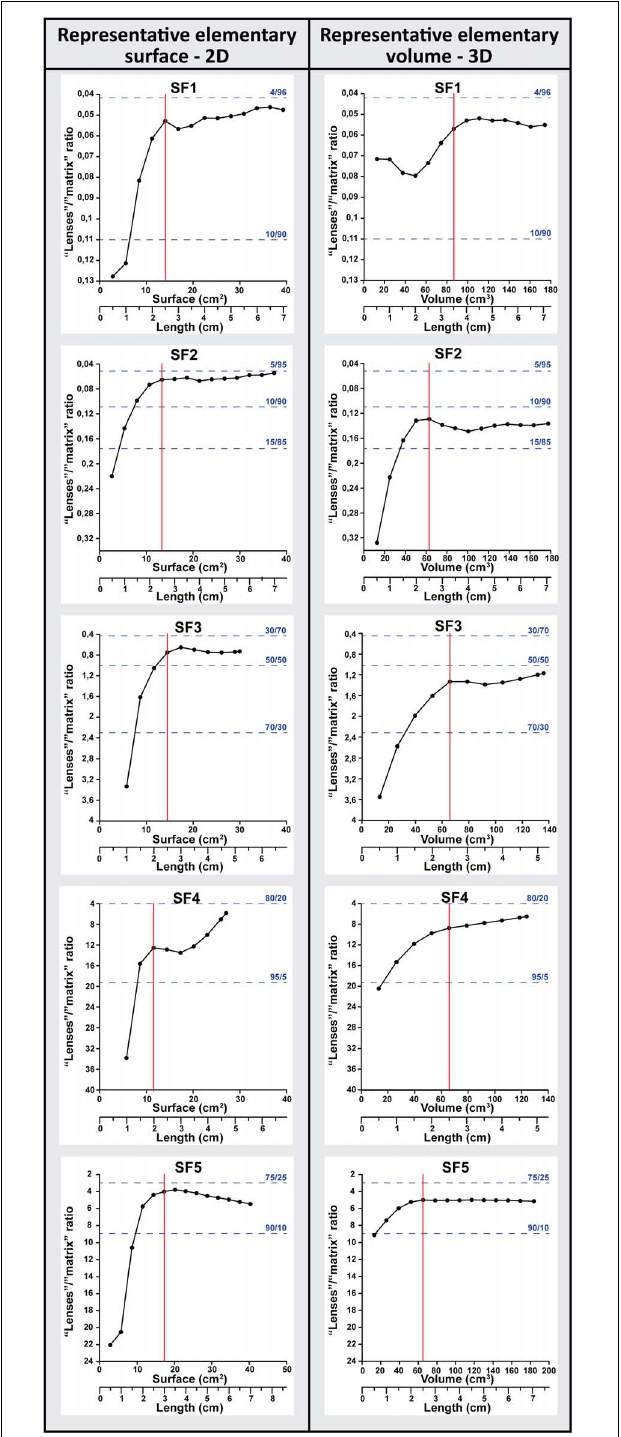
FIGURE 11 | Representative elementary surfaces (left column) and volumes (right column) per subfacies type, with respect to “lenses”/“matrix” fraction ratios, and based on a single drill core with fixed diameter (67 mm). The slightly different “lenses”/“matrix” ratios between the 2D RES and 3D REV (up to about 10% in SF3) might partly be explained by the tilting of the bedding